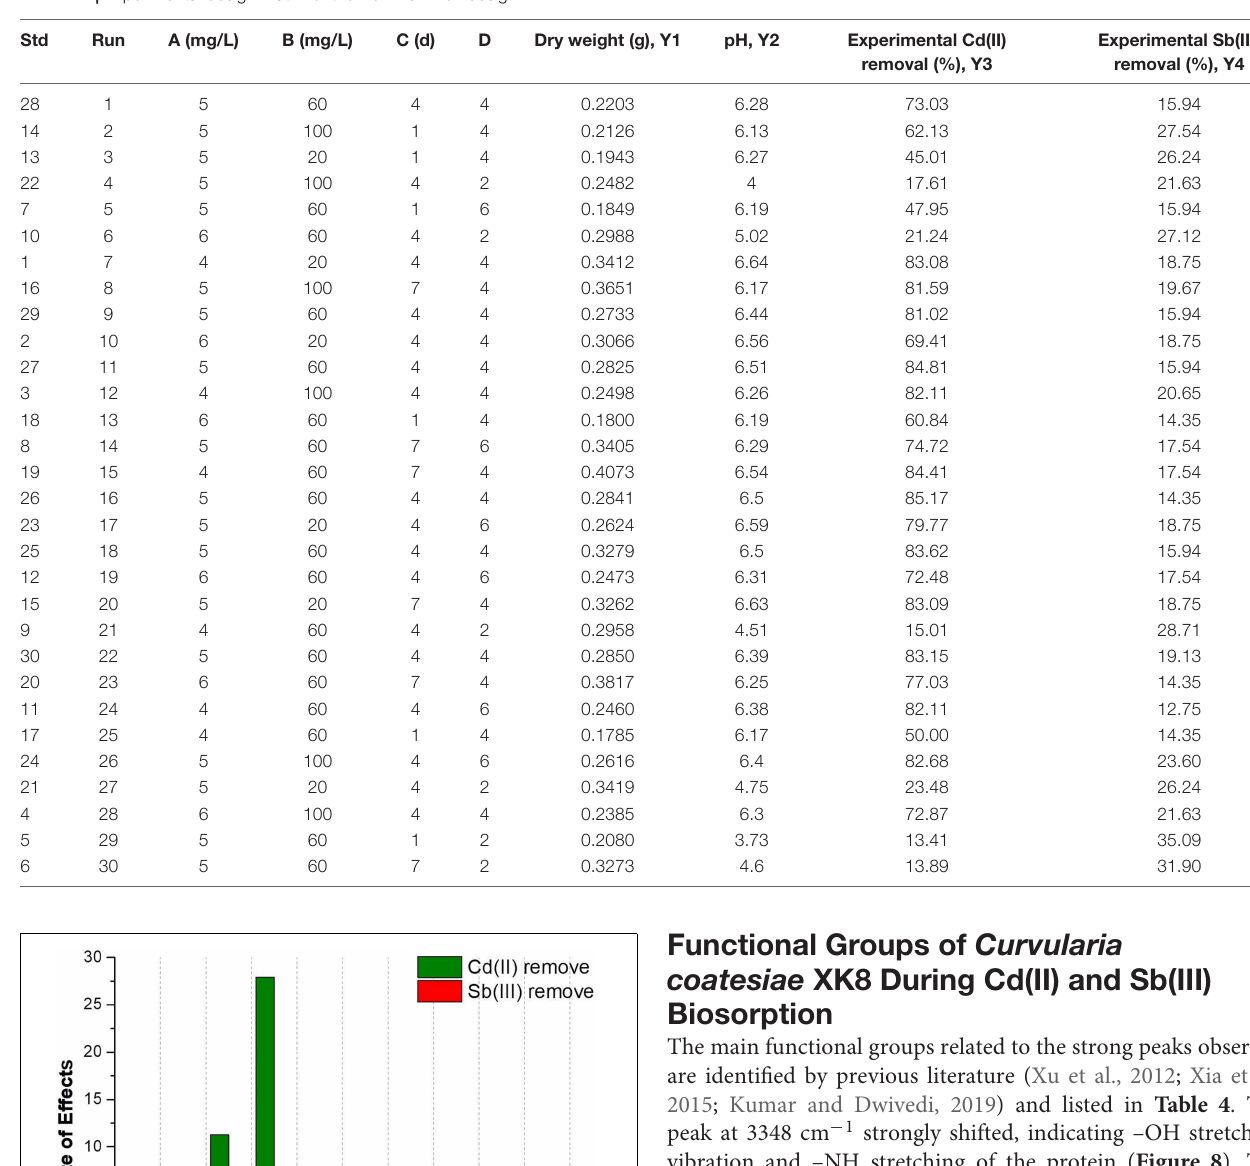
TABLE 2 | Experimental design matrix of the Box-Behnken design.